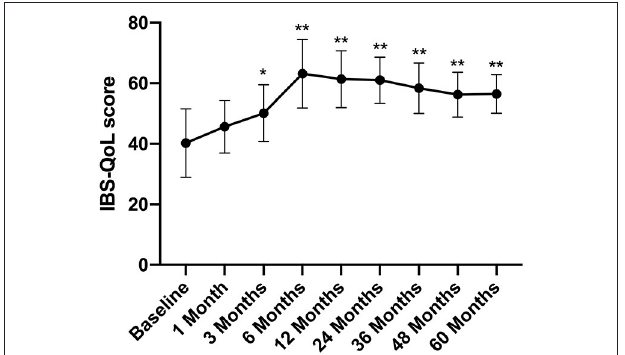
FIGURE 3 | IBS-QoL score between groups and the change over time. Difference was compared between each time point of follow-up and before FMT (baseline). IBS-QoL, IBS-specific quality of life. Data are presented as x ± s, statistical analyses: univariate analysis of variance, * p < 0.05, ** p < 0.01.